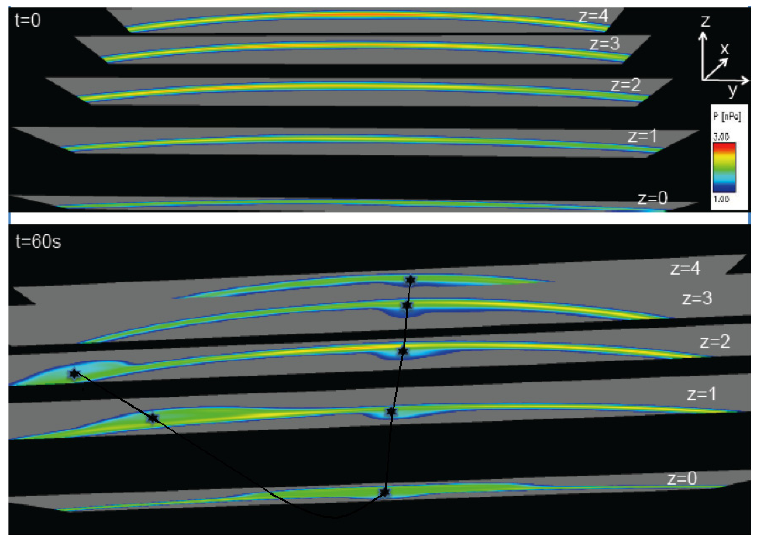
Fig. 10. Plasma pressure evolution for the z cuts ( z = 0, 1, 2, 3, 4 R E ) at t = 0 (top image) and t = 60s (bottom image). The observer sees the plots from bottom to top and anti-sunward.